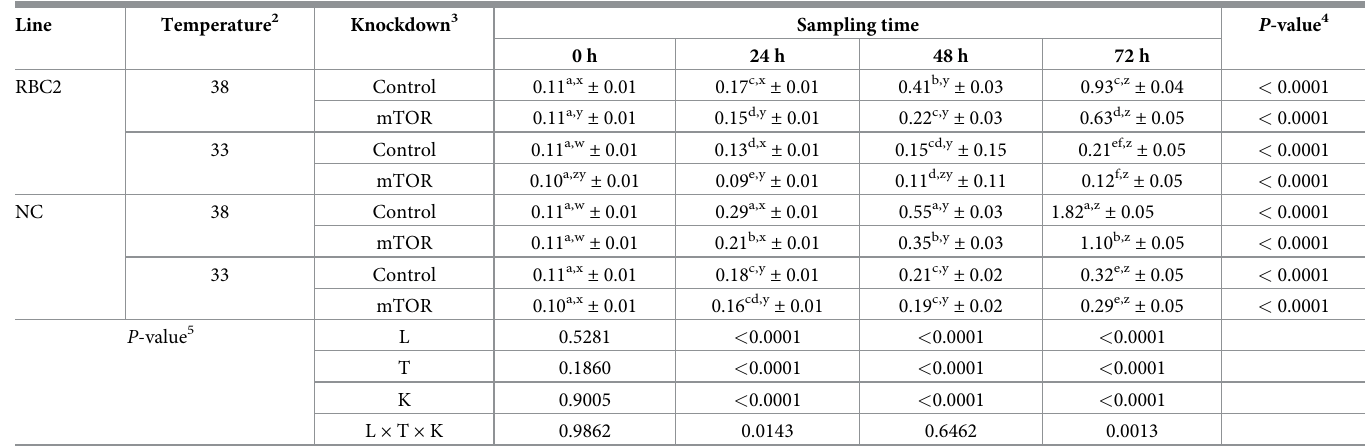
Table 3. Effect of cold stress (33˚C) and knockdown of mTOR on RBC2 and NC line SC proliferation 1